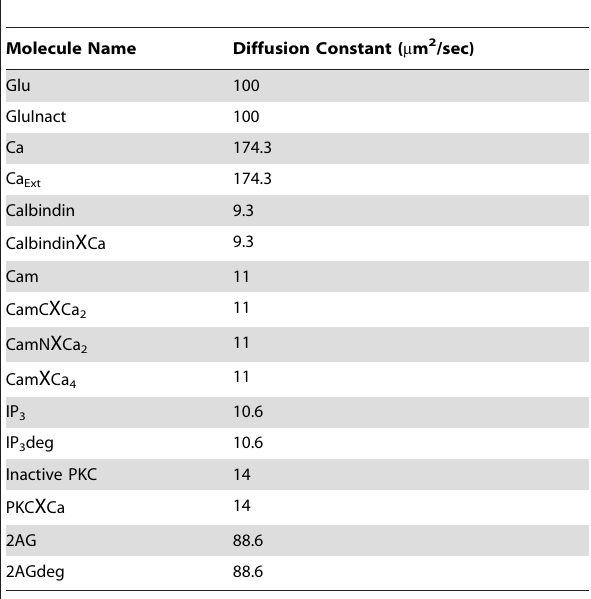
Table 3. Diffusion constants for diffusible molecules in the